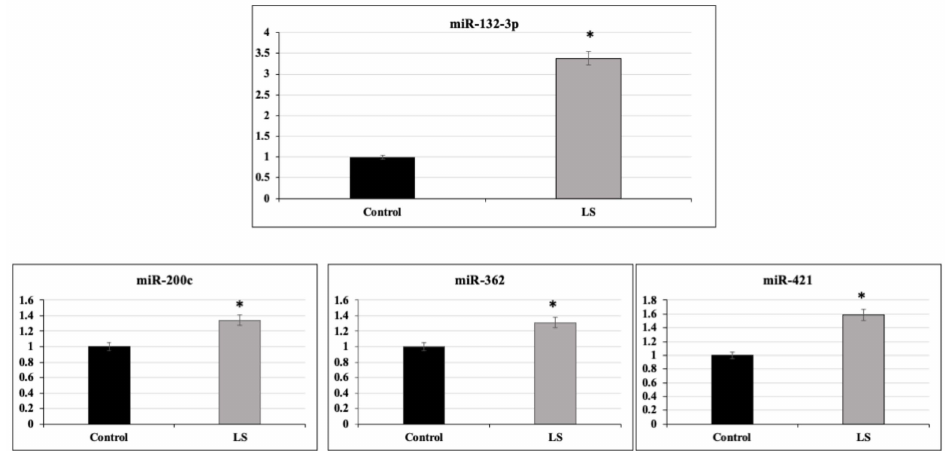
Figure 2. Validation analysis of selected miRs. Selected miRs that display fold-changes larger than 1.5 between LS patients and controls in microRNA arrays were selected for further validation by qRT-PCR. The selected miRs include: miR-132- 3p, miR-421-3p, miR-200c-3p and miR-362-5p. Total RNA was prepared from EBV-immortalized lymphoblastoid cells derived from patients and controls analyzed in microRNA arrays; miRs levels were measured using appropriate primers, as described in the Section 4. * p < 0.01 versus respective control